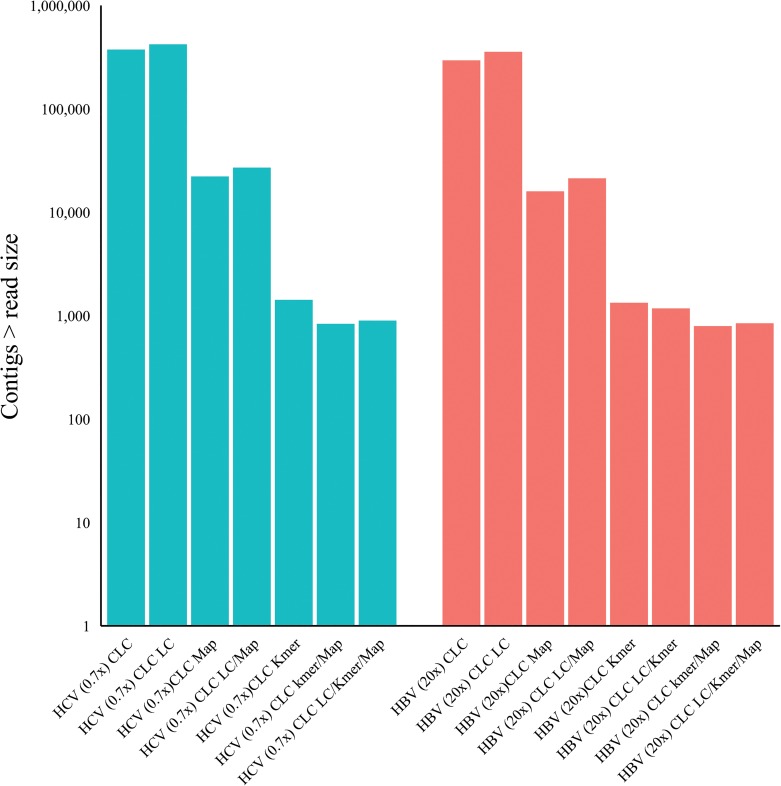
Effect of k-mer filtering (k-mer) / mapper subtraction (Map) and lowcomplexity filtering (LC) on post-assembly contig numbers.